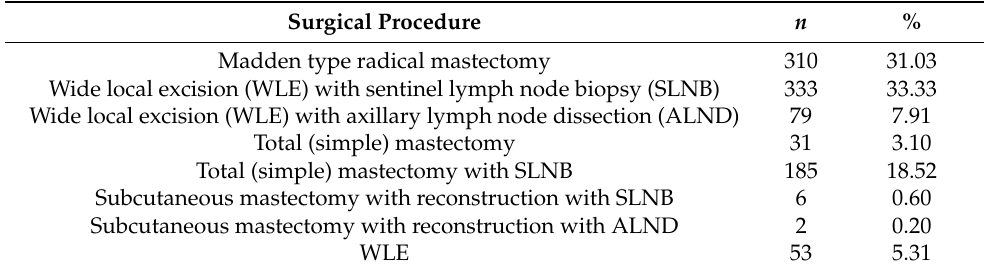
Table 3. Surgical procedures.